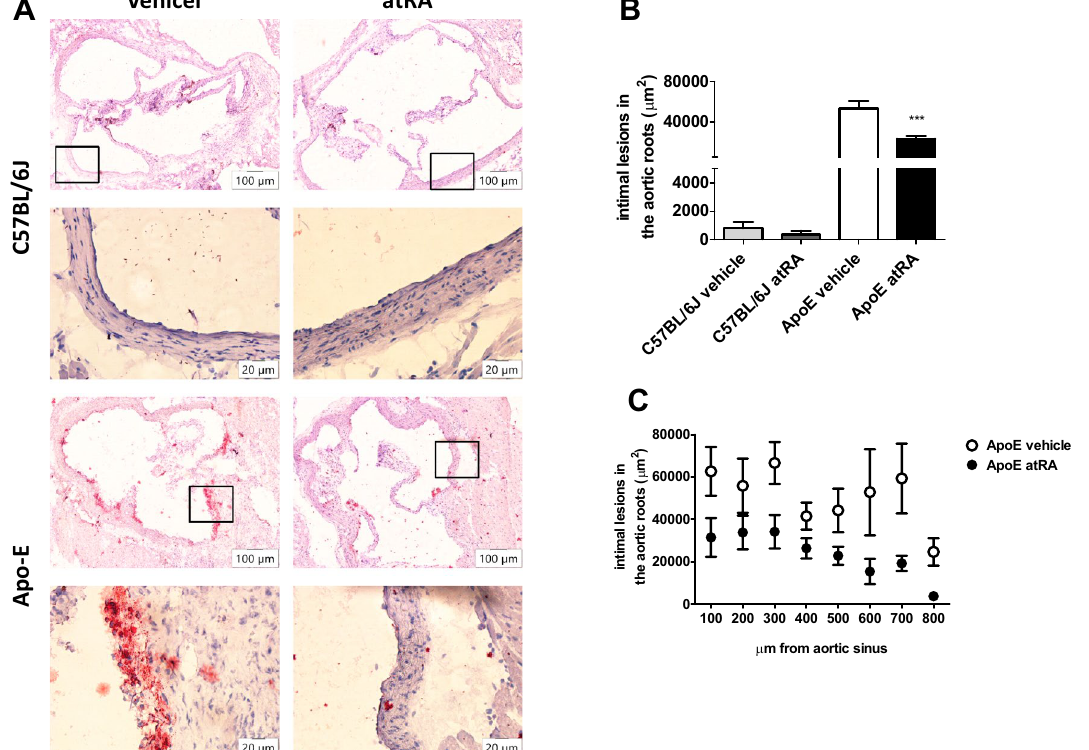
Figure 2. Microscopic analysis of the intimal lesions in the aortic roots. All-trans-retinoic acid (5 mg/kg/ day) or vehicle (corn oil) were administered orally by plastic feeding tubes to Apo-E and C57BL/6J mice for 8 weeks. ( A ) The Oil Red O-stained cross-sections of the aortic roots revealing the area of the lesions (magnification × 10 and × 40). ( B ) Average size of the atherosclerotic plaques in the aortic root. ( C ) Average sizes of the atherosclerotic lesion areas of eight individual cross-sections of the aortic root of each mouse. Data are expressed as the mean ± SEM of 5–6 mice per group. The results were analyzed by one ‐ way ANOVA with Tukey’s Multiple Comparison Test. ***p < 0.001 ApoE atRA vs. ApoE